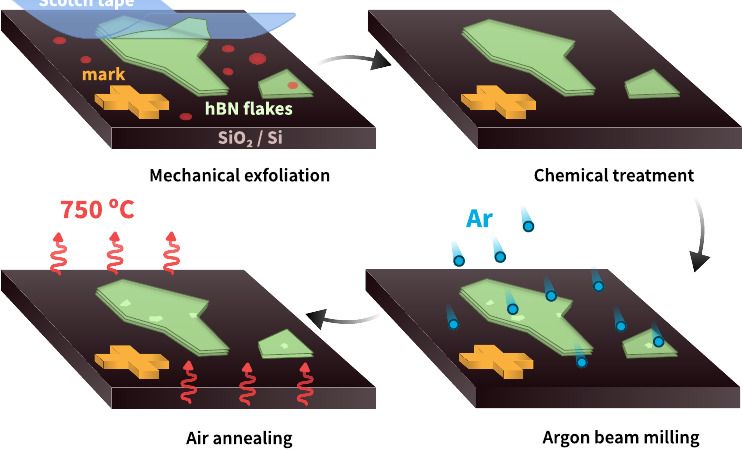
Figure 1. Sample fabrication scheme: mechanical exfoliation and transferring of hBN flakes to the substrate using scotch tape; chemical treatment to clean off the dirt and glue; introduction of structural defects in the flakes with an argon beam; high-temperature annealing in air to activate the